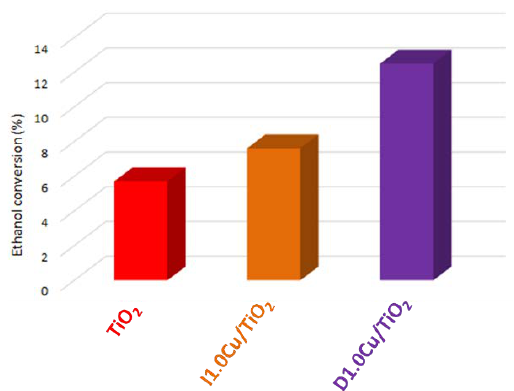
Figure 11. Ethanol conversion on TiO 2 and CuO-loaded TiO 2 photocatalysts.